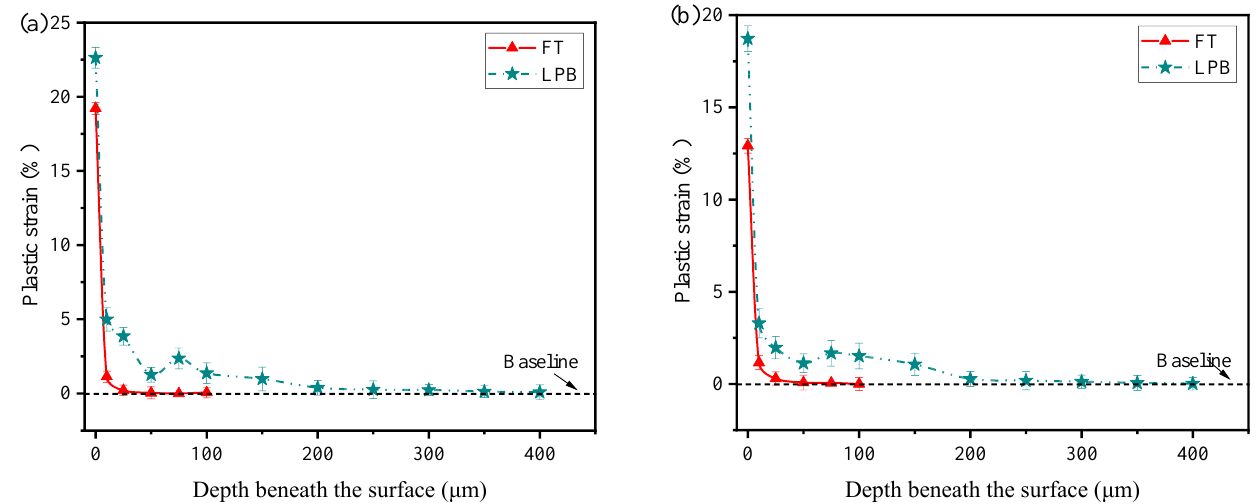
Figure 14. Plastic strain distribution in depth beneath the surface in the ( a ) longitudinal direction and ( b ) transverse direction.